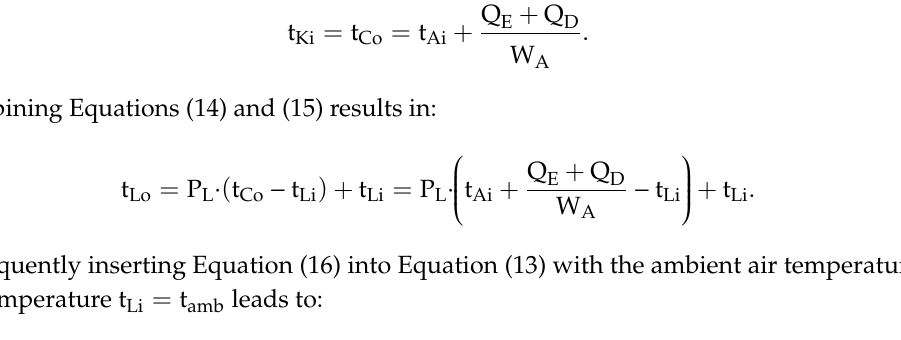
( b ) Figure 4. Comparison of the measured and calculated values for the absorption chiller and dry-cooler model as a function of time ( a ) and for the absorption chiller as a function of the inlet characteristic temperature difference ( b ). 3. Results—Model Predictive Control The model predictive control strategy for an extended solar heat operation of the SAC system combines the absorption chiller model (i.e., the improved characteristic equation method) with a part load model for the reject heat device. Since the combination of absorption chillers with dry coolers has become increasingly more common and the humidifier at the Federal Environment Agency in Dessau is normally blocked, a dry-cooler model is sufficient. After the description of the dry-cooler model, the control strategy is derived. 3.1. Dry-Cooler Model In Figure 5, the nomenclature for the dry-cooler model is depicted. A control signal C (cid:2888)(cid:2887) is used to adjust the air flow rate V(cid:4662) (cid:2896) by changing the rotational speed of the ventilators or their motors, respectively. The necessary electrical power of the dry-cooler P (cid:2915)(cid:2922),(cid:2888)(cid:2887) for a certain air flow rate V(cid:4662) (cid:2896) is proportional to the pressure drop and total efficiency η (cid:2888)(cid:2887),(cid:2930)(cid:2925)(cid:2930) , including all mechanical and electrical losses of the motor-ventilator assembly. In addition, a constant auxiliary power consumption P (cid:2915)(cid:2922),(cid:2888)(cid:2887)(cid:2911)(cid:2931)(cid:2934)